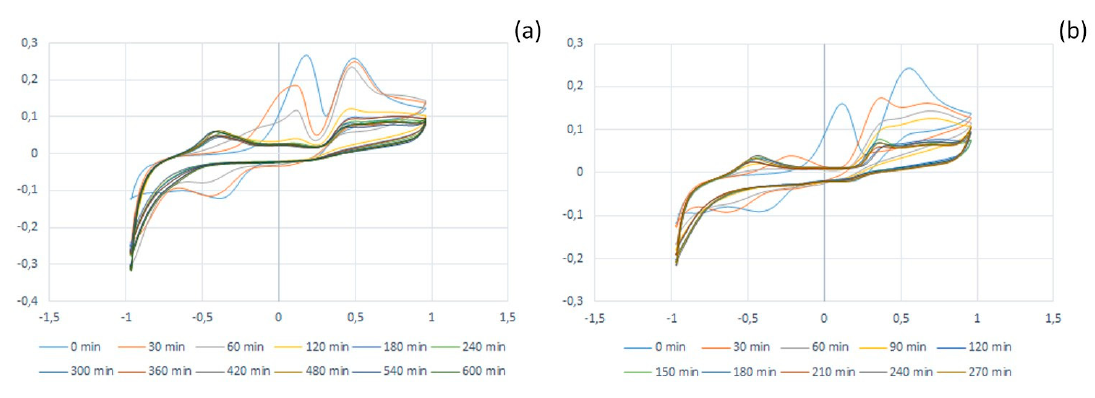
Figure 2. Electrochemical fingerprint of FODMAP related compounds released during ( a ) chickpeas and ( b ) lentils soaking for 10 h and 4.5 h,